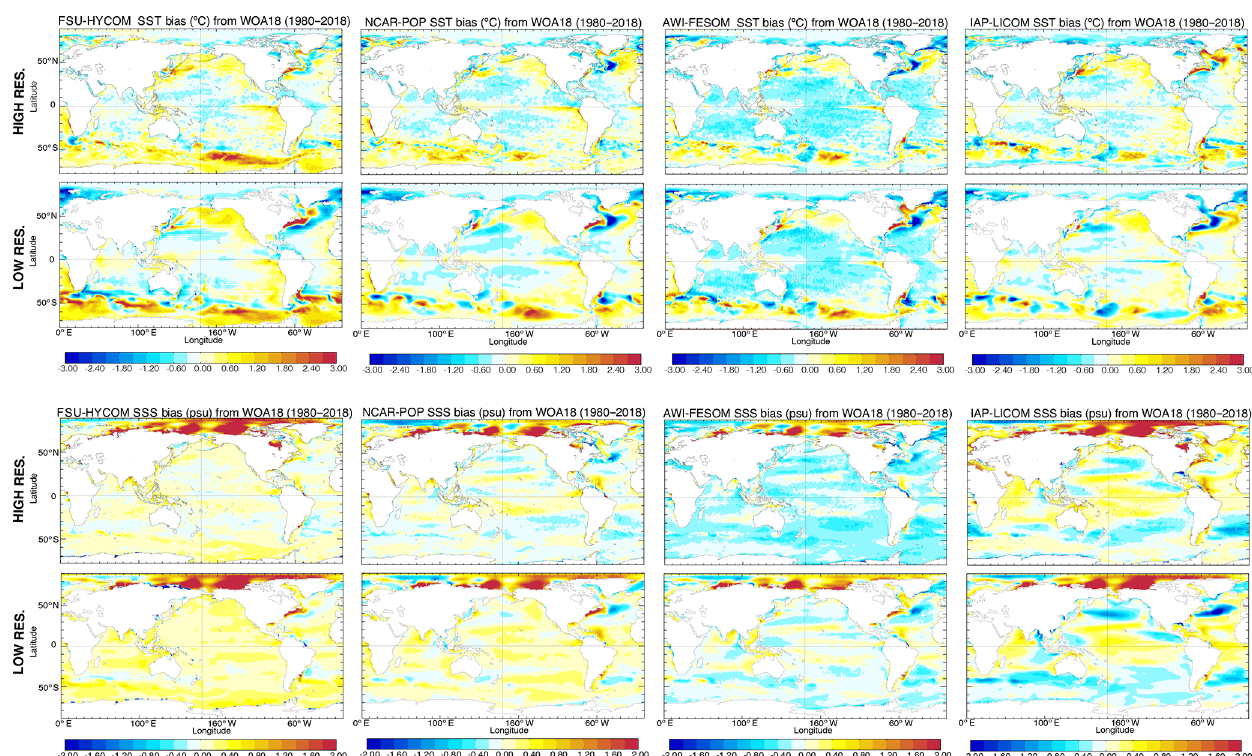
Figure 10. Modeled surface temperature ( ◦ C) and salinity (psu) difference from WOA18 over the 1980–2018 time